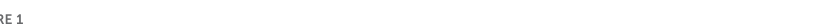
FIGURE1 increased at 6h after modeling and returned to the normal level at 14 days ( n = 7). RF, right forelimb; LF, left forelimb; RH, right hind limb; LH, left hind limb. Swing (s): the duration in seconds of no contact of a paw with the glass plate. Mean intensity: the mean intensity of the complete paw. Max Intensity At (s): the time in seconds since the start of the run that the maximum intensity is measured. Max Contact Max Intensity: the maximum intensity at max contact of a paw. The intensity of a print depends on the degree of contact between a paw and the glass plate and increases with increasing weight. * p < 0.05 vs. normal group.